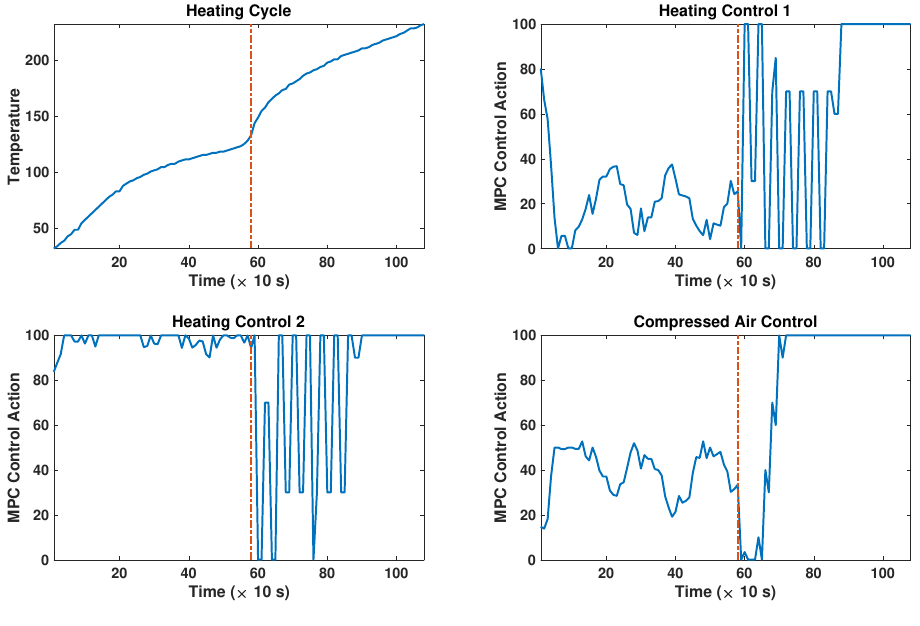
Figure 5. Varying blends constrained